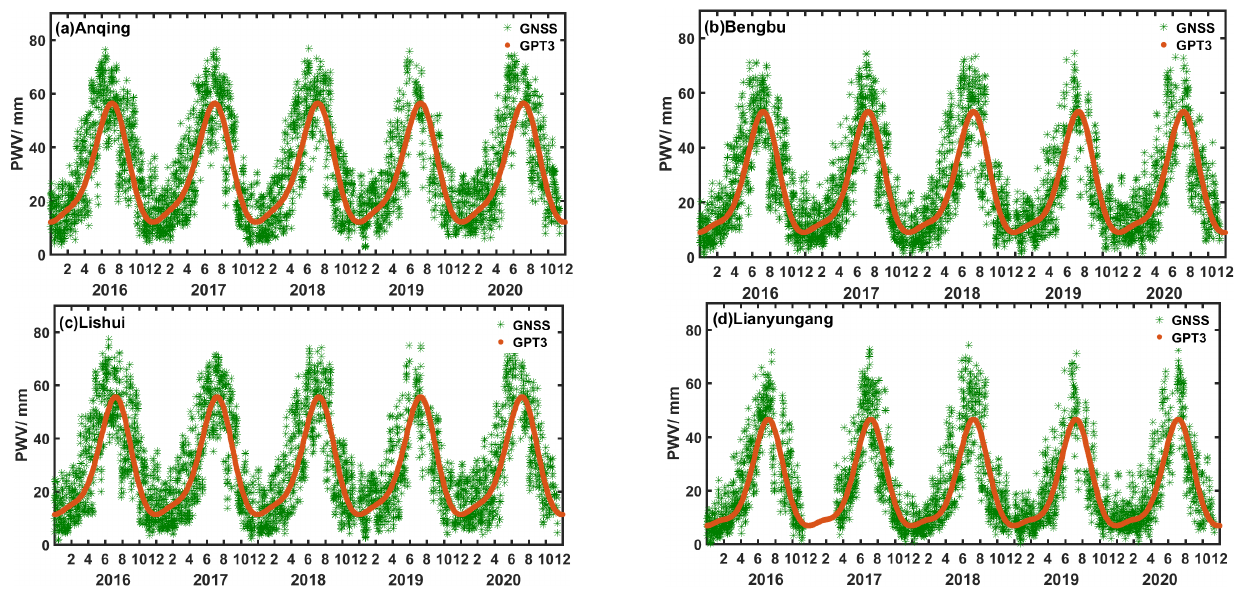
Figure 8. Time series variation of GPT3-PWV and GNSS-PWV in Anqing ( a ), Bengbu ( b ), Lishui ( c ), and Lianyungang ( d ) during 2016–2020.